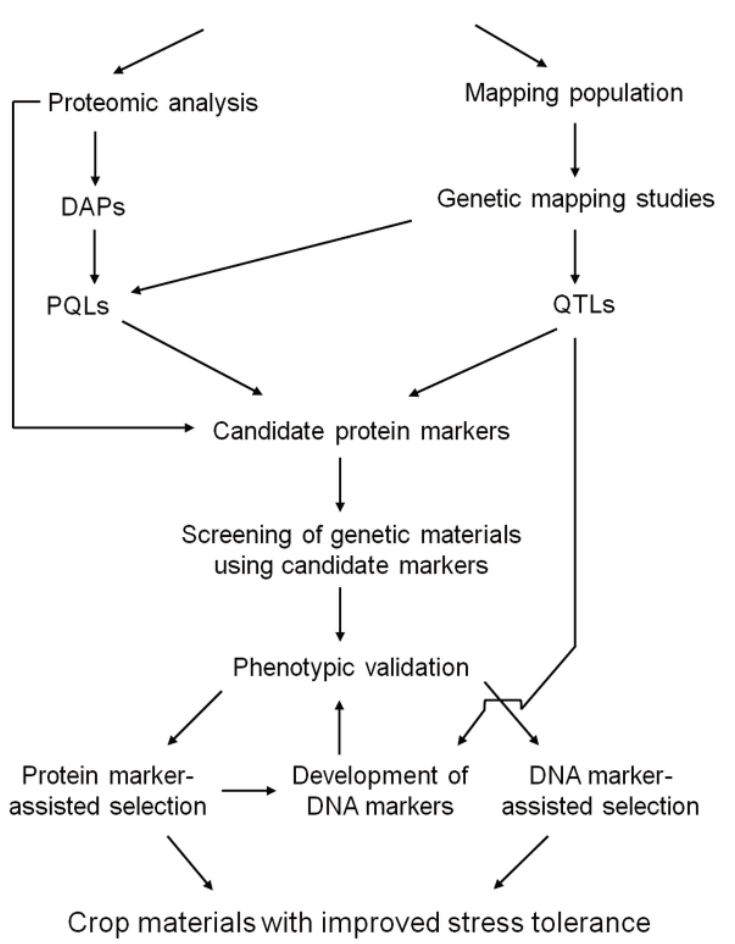
Figure 2. A schematic workflow of the utilization of candidate protein markers in breeding for an improved crop stress tolerance. Abbreviations: DAPs—differentially abundant proteins; PQL—protein quantitative loci; QTL—quantitative trait